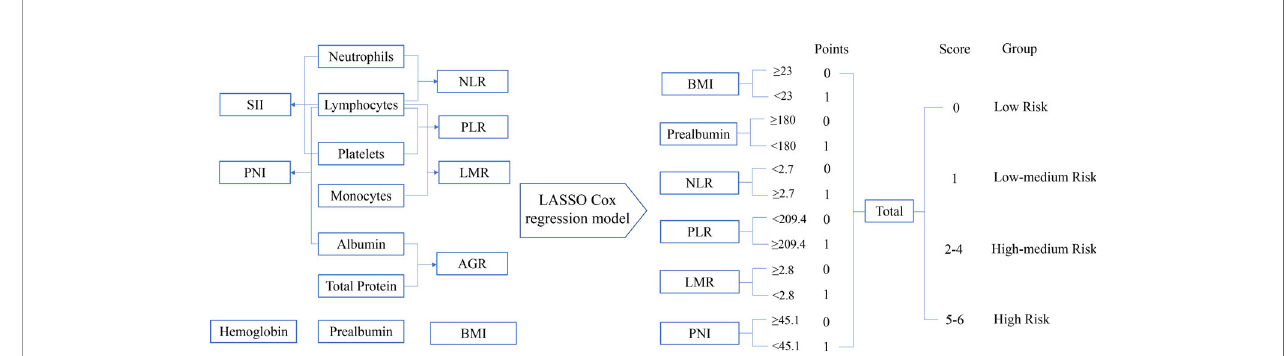
FIGURE 1 | The process diagram of INPS construction and risk strati fi cation. NLR, neutrophil-lymphocyte ratio=N/L; PLR, platelet-lymphocyte ratio=P/L; LMR, lymphocyte-monocyte ratio=L/M; SII, systemic immune in fl ammation index=P×N/L; PNI, prognostic nutritional index=albumin (g/L)+5×L (10 9 /L) (P, platelet count; N, neutrophil count; L, lymphocyte count; M, monocyte count); AGR, albumin-globulin ratio=albumin/(total protein-albumin); BMI, body mass index=weight(kg)/height(m) 2 ; INPS, in fl ammatory-nutritional prognostic score.